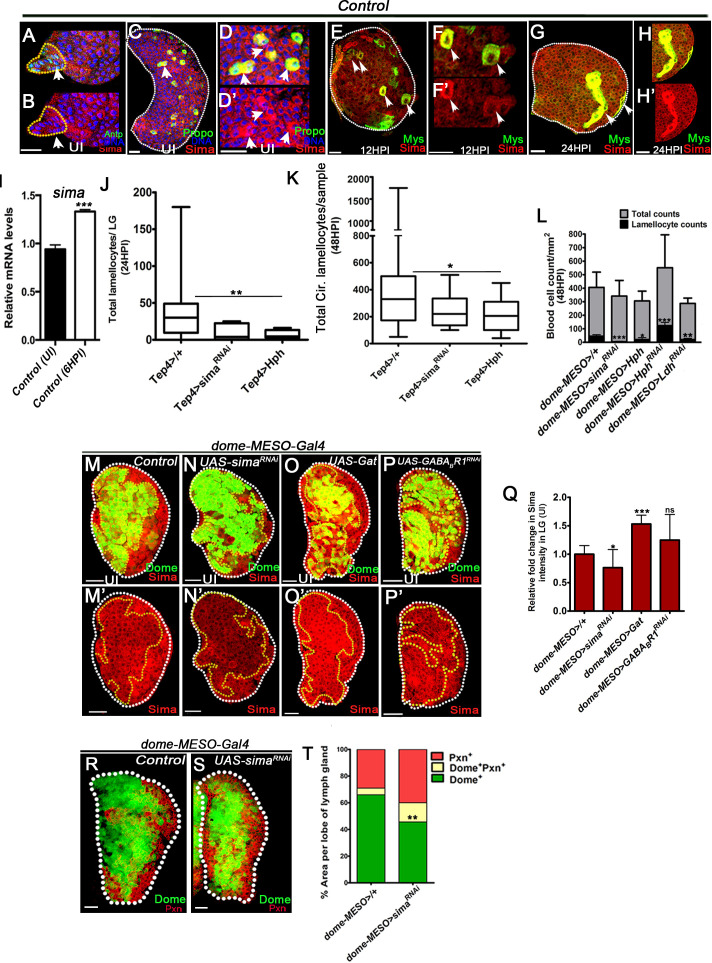
Sima function during larval hematopoiesis establishes lamellocyte potential.DNA is stained with DAPI (blue). In lymph gland, lamellocytes analyzed at 24HPI and in circulation at 48HPI. Sima stainings (red) in panels (A–H) and (M–P’). Dome-GFP-positive area marks progenitor area and Pxn-positive area marks differentiating pool of blood cells (in panels y, y). In panels (A-H’, M-P’, R and S) scale bar = 20 µm. HPI indicates hours post wasp-infection, RF is regular food, and SF is succinate food. Panels (I, L, Q and T) represents mean ± standard deviation (mean ± SD), and panels (J and K) show median in box plots and vertical bars represent upper and lowest cell counts. Statistical analysis in panels (I, L, Q and T) is unpaired t-test, two-tailed and in panels (J and K) is Mann-Whitney test, two-tailed. ‘n’ represents the total number of larvae analyzed, and for lymph gland ‘n’ represents lymph gland lobes analyzed. ns is nonsignificant. For better representation of the lymph gland primary lobes, the images shown have been edited for removal of adjacent tissues (like dorsal vessel and ring gland). (A, B) Control (dome-MESO-Gal4, UAS-GFP/+) lymph gland from 3rd instar larvae obtained from uninfected animals showing (A) Sima protein expression (red) in the posterior signaling center (PSC) cells marked with Antp (green, area marked within yellow dotten line and white arrows head). Image in (B) shows Sima (red) in PSC cells (marked with yellow dotted line). (C–D’) Control (dome-MESO-Gal4, UAS-GFP/+) lymph gland from 3rd instar larvae obtained from uninfected condition showing elevated Sima protein expression (red) in crystal cells (ProPoA, green and marked with white arrows head). (D, D’) Zoomed images of elevated Sima expression in crystal cells. (E–F’) Control (Or49a-Gal4/+) lymph gland at 12HPI showing elevated Sima protein expression (red) in lamellocytes (co-stained with Myospheroid (Mys) in green and indicated with white arrowheads). (F, F’) show zoomed images of elevated Sima expression in lamellocytes at 12HPI. (G–H’) Control (Or42a-Gal4/+) lymph gland at 24HPI, showing elevated Sima protein expression (red) in lamellocytes (co-stained with Myospheroid (Mys) in green and indicated with white arrowheads). (H, H’) show zoomed images of elevated Sima expression in lamellocytes at 24 HPI. (I) Relative mRNA quantification of sima in control lymph glands obtained from uninfected and wasp-infected 3rd instar larvae at 6 HPI (***p<0.0001). (J, K) Quantifications of lamellocyte counts in (J) lymph gland in Tep4-Gal4, UAS-mCherry/+ (control, n = 25), Tep4-Gal4, UAS-mCherry; UAS-simaRNAi (n = 5, ns), Tep4-Gal4, UAS-mCherry; UAS-Hph (n = 14, **p=0.0027) and in (K) circulation Tep4-Gal4, UAS-mCherry/+ (control, n = 38), Tep4-Gal4, UAS-mCherry; UAS-simaRNAi (n = 13, ns), Tep4-Gal4, UAS-mCherry; UAS-Hph (n = 20, *p=0.0231). (L) Quantification of total circulating blood cell numbers per mm2 in animals at 48 HPI. Represented here are the numbers of lamellocytes (black bar) and total cell counts (gray bar) counted per mm2. No significant difference in overall cell density is detected, although significant reduction in lamellocyte numbers is seen in dome-MESO-Gal4, UAS-GFP; UAS-simaRNAi (n = 5, ***p<0.0001), dome-MESO-Gal4, UAS-GFP; UAS-Hph (n = 5, *p=0.0172) and an increase in dome-MESO-Gal4, UAS-GFP; UAS-HphRNAi (n = 5, ***p=0.0004), a decrease in dome-MESO-Gal4, UAS-GFP; UAS-LdhRNAi in (n = 5, **p=0.0055) and in comparison to dome-MESO-Gal4, UAS-GFP/+ (control, n = 5). (M–P’) Compared to Sima protein expression (red) in lymph glands from 3rd instar (M, M’) control (dome-MESO-Gal4, UAS-GFP/+) animals, a (N, N’) downregulation is seen in progenitor cells expressing simaRNAi (dome-MESO-Gal4, UAS-GFP; UAS-simaRNAi). (O, O’) Gat over-expressing progenitor cells (dome-MESO-Gal4, UAS-GFP; UAS-Gat) show elevated Sima protein expression in them. Compared to control (R, R’) GABABR1RNAi-expressing progenitor cells (dome-MESO-Gal4, UAS-GFP; UAS-GABABR1RNAi) show comparable sima expression. Images in M’–P’ show sima expression (red) of the respective images shown in M–P without GFP for better clarity. (Q) Relative fold change in Sima expression in dome-MESO-Gal4, UAS-GFP/+ (control, n = 12), dome-MESO-Gal4, UAS-GFP; UAS-simaRNAi (n = 10, *p=0.0326), dome-MESO-Gal4, UAS-GFP; UAS-Gat (n = 15, ***p<0.0001) and dome-MESO-Gal4, UAS-GFP; UAS-GABABR1RNAi (n = 10, ns). (R, S) 3rd instar lymph glands from (R) control (dome-MESO-Gal4, UAS-GFP/+) and, (S) lymph glands expressing simaRNAi in progenitor cells (dome-MESO-Gal4, UAS-GFP; UAS-simaRNAi). No dramatic change in lymph gland development is seen but progenitor maintenance (Dome+, green) and differentiation (Pxn+, red) marker analysis reveals a mild increase in Dome+Pxn+ cells, see quantification in (T). (T) Graphical representation of percentage areas of progenitor cells (green, Dome+ only), intermediate population (IP, yellow, Dome+ Pxn+) and differentiating blood cells (red, Peroxidasin+ only) in 3rd instar larval lymph gland. An expansion of IP is noted in genetic knock-down of sima, dome-MESO-Gal4, UAS-GFP; UAS-simaRNAi (n = 15, **p=0.0089) as percentage area distribution in comparison to dome-MESO-Gal4, UAS-GFP/+ (control, n = 6).Figure 3—figure supplement 1—source data 1.Contains numerical data plotted in Figure 3—figure supplement 1I,J,K,L,Q and T.